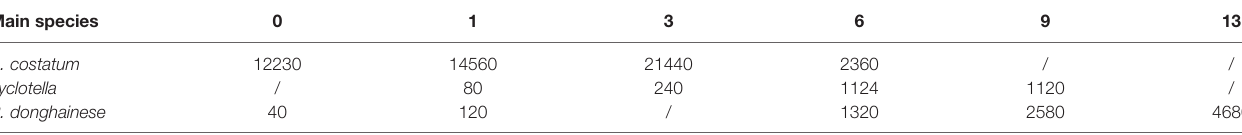
Because the phytoplankton assemblages made the inaccurate count of the abundance, not all sample data were recorded. We just identi fi ed the dominant species in four groups which showed the similar succession process. “ / ” means it was not clearly found in the